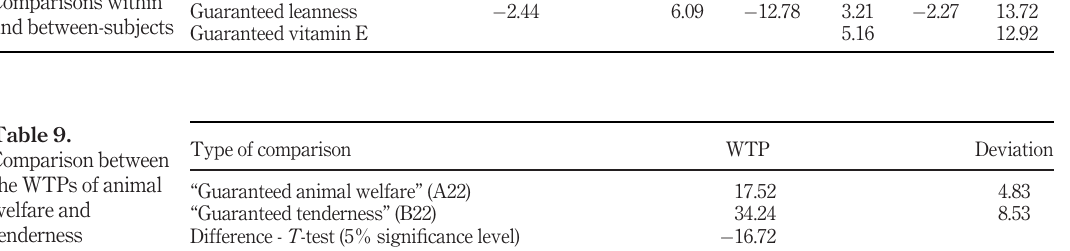
Table 8. Comparisons within and between-subjects